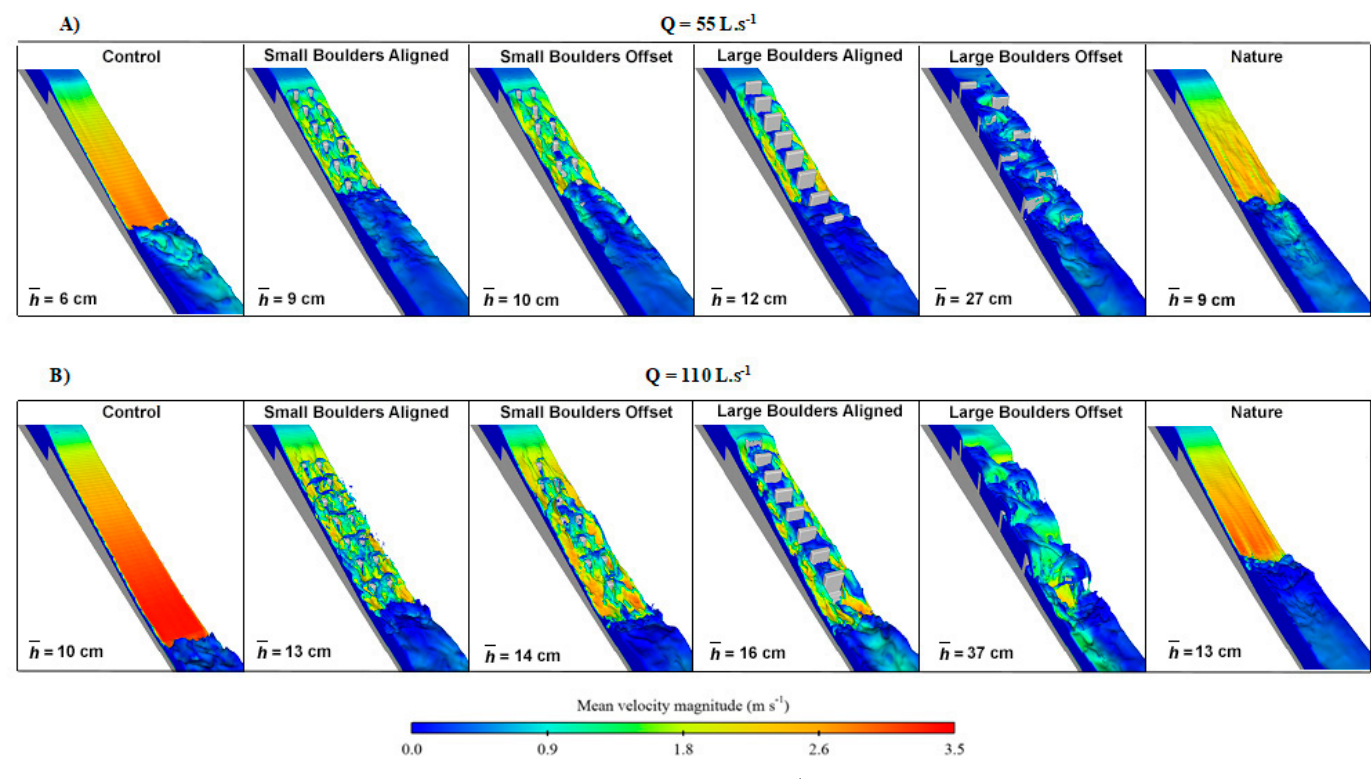
1/2 Figure 4. Characterization of the mean water velocity magnitude ( U = ( u (cid:48) 2 + v (cid:48) 2 + w (cid:48) 2 ) ; m · s − 1 ) for each configuration tested, using the computational fluid Figure 4. Characterization of the mean water velocity magnitude ( 𝑈(cid:3365) = (𝑢′ (cid:2870) + 𝑣′ (cid:2870) + 𝑤′ (cid:2870) ) 1/2 ; m·s − 1 ) for dynamics (CFD) commercial software FLOW-3D ® , considering the discharges of: ( A ) 55 L · s − 1 , and ( B ) 110 L · s − 1 . Mean water depths over the ramp ( h ; cm) is also each configuration tested, using the computational fluid dynamics (CFD) commercial software presented for each FLOW-3D ® , considering the discharges of: ( A ) 55 L·s − 1 , and ( B ) 110 L·s − 1 . Mean water depths over the ramp ( ℎ(cid:3364) ; cm) is also presented for each configuration.